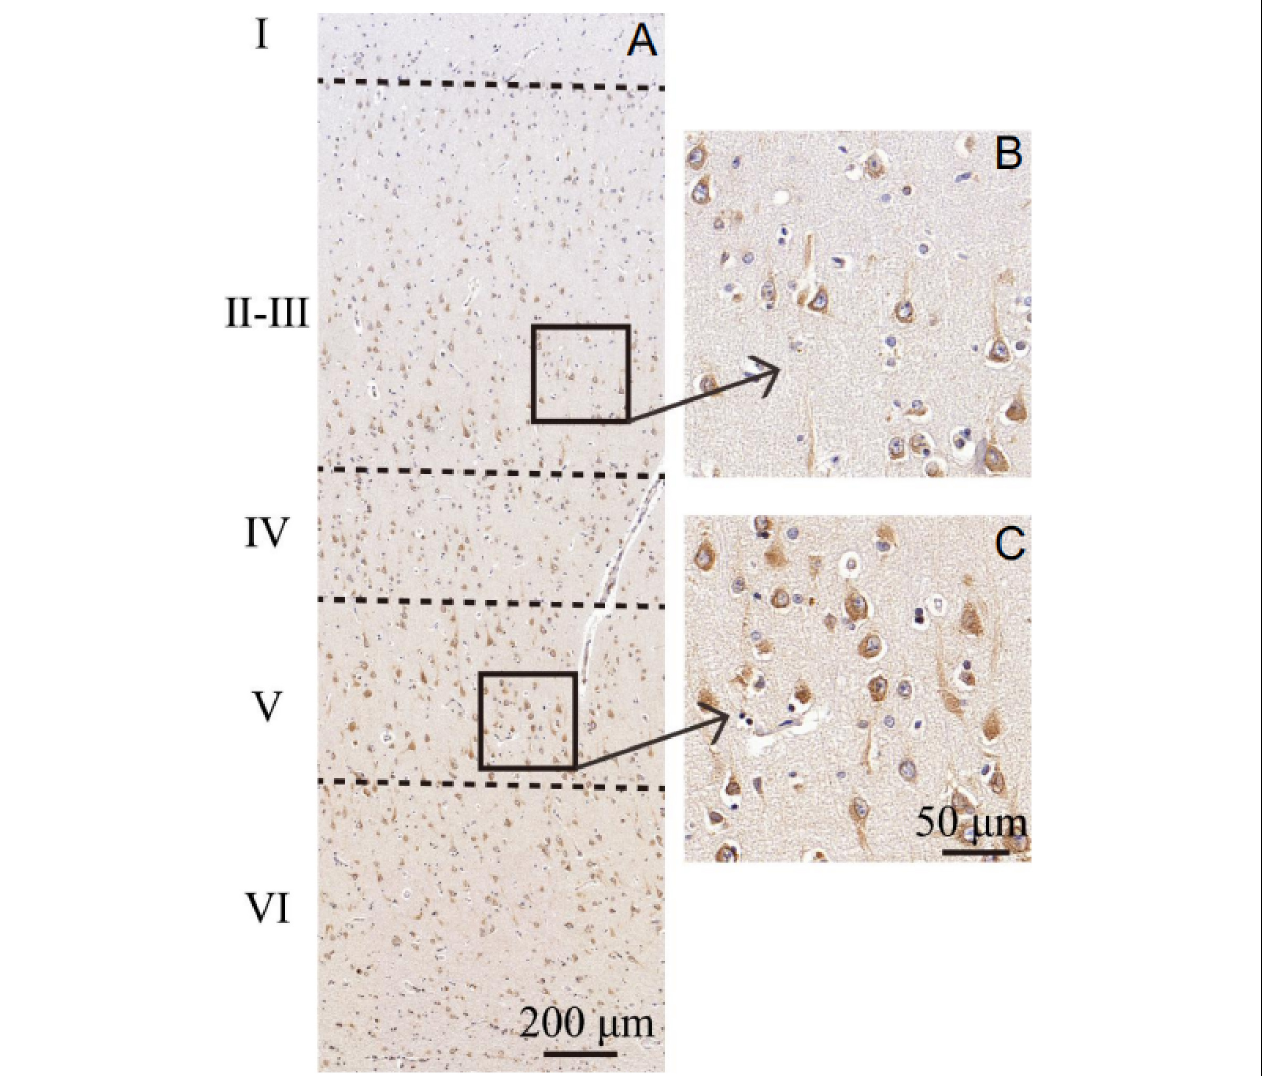
FIGURE 4 | Cytoarchitecture of the ITGC. (A–C) Organization of cortical laminae visualized in tissue sections immunolabeled with an antibody against MANF. Layers are indicated by roman numerals. Scale bar, 200 µ m (A) and 50 µ m (B,C) .